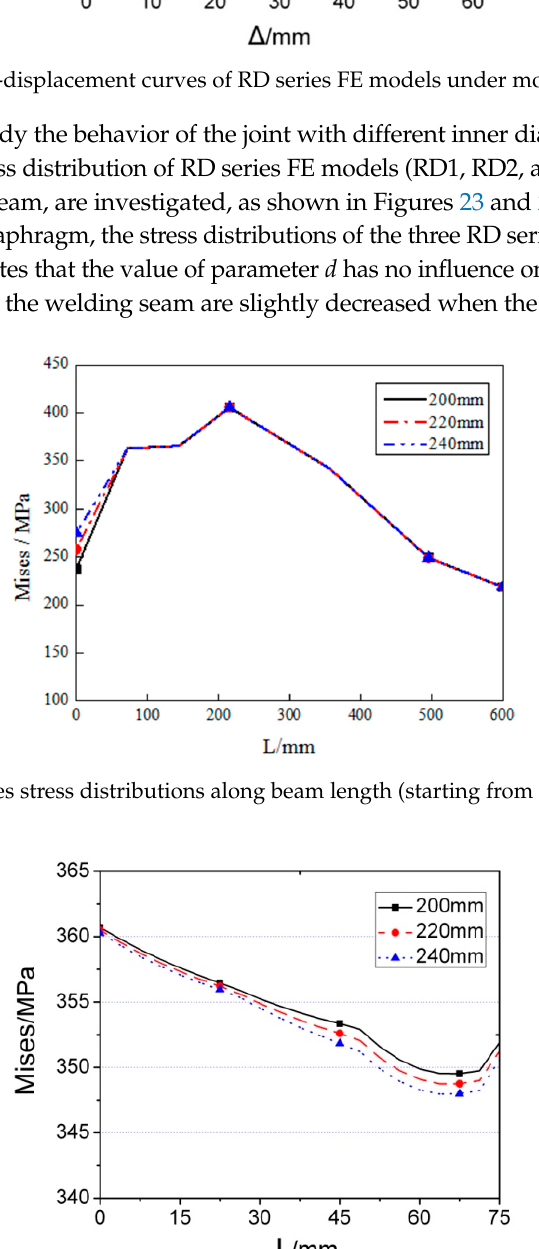
Figure 24. The Von Mises stress distributions along welding seam length (starting from edge to middle of welding seam) of RD series FE joint